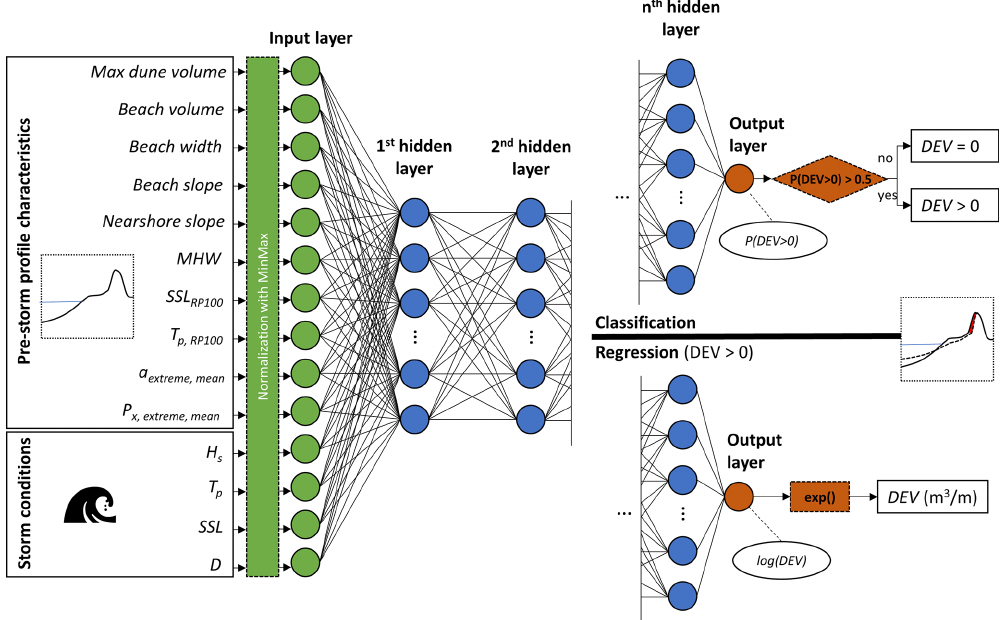
Figure 5. Configuration of the artificial neural network (ANN) for either DEV classification or regression. The first layer (input layer) comprises 14 (10 profile and 4 forcing) parameters, which are normalized. Then, n hidden layers with variable numbers of nodes are defined iteratively, while connections to the nodes of the previous layer are established using weights, biases and an activation function. The last layer is the output layer for which there can be two configurations: (1) classification (upper right), where the output layer comprises one node presenting the probability of DEV > 0, which provides an estimate of dune erosion occurrence or not, and (2) regression (lower right), where the output layer comprises one node, which is the log(DEV) that is translated back to its real units using an exponential